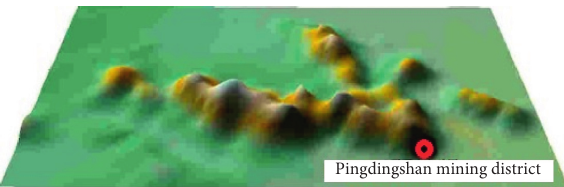
Figure 3: Three-dimensional topography of the Pingdingshan mine